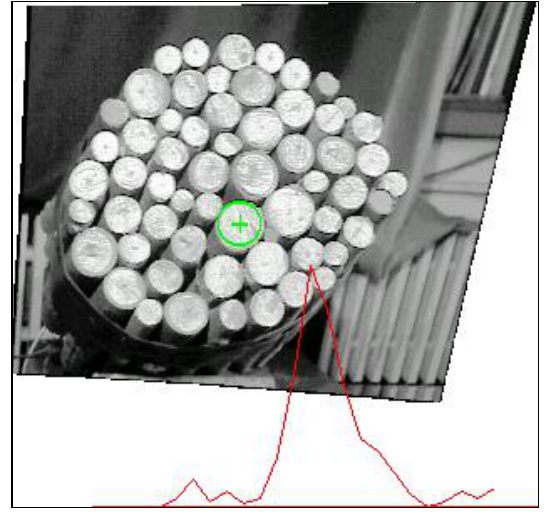
Figure. 6. Example of function of a number of appropriate contour points for each value of possible circle